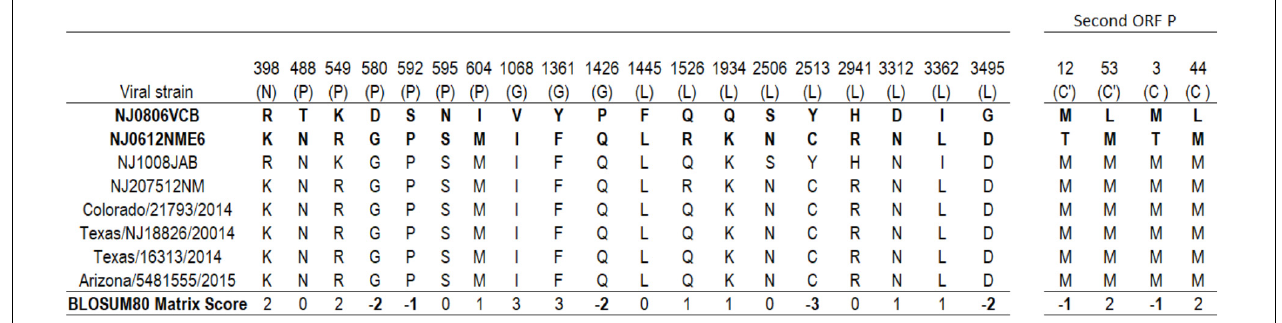
FIGURE 3 | Amino acid differences between viral strain NJ0806VCB (1.2) and different viral strains from lineage 1.1. Numbers in the headings of each column represent the specific locations in the concatenated coding sequence of VSNJV, and letters in parenthesis denote the corresponding viral protein where the predicted substitution occurs. The BLOSUM80 matrix score at different positions reflects the biological meaningfulness of the amino acid substitution (see “Materials and Methods” section).